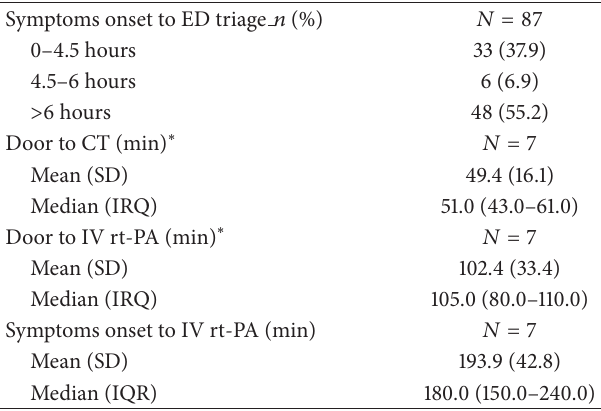
Table 1: Time analysis for patients with IV